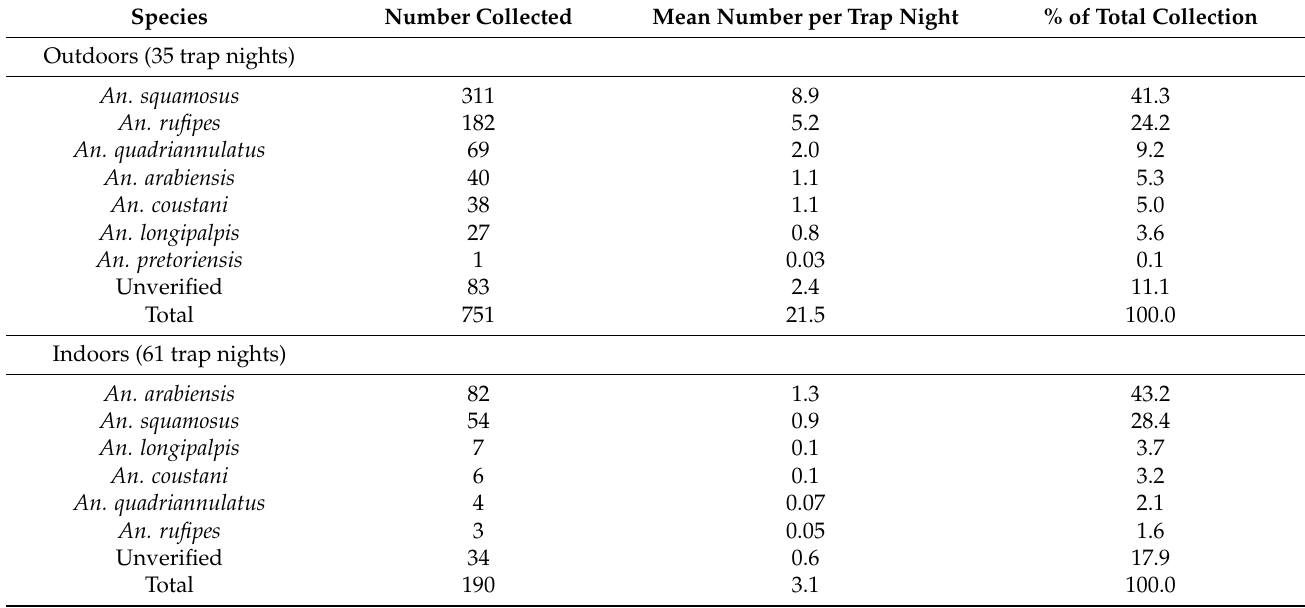
Table 1. Molecular species composition of the reactive test-and-treat collections from December 2017–June 2018. Species Number Collected Mean Number per Trap Night Outdoors (35 trap